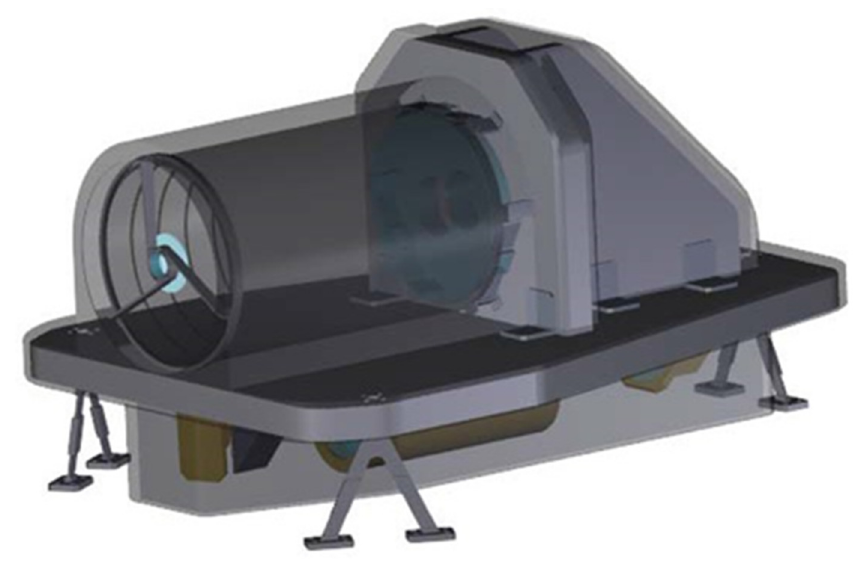
Figure 14. Overview of the mechanical assembly of the instrument.